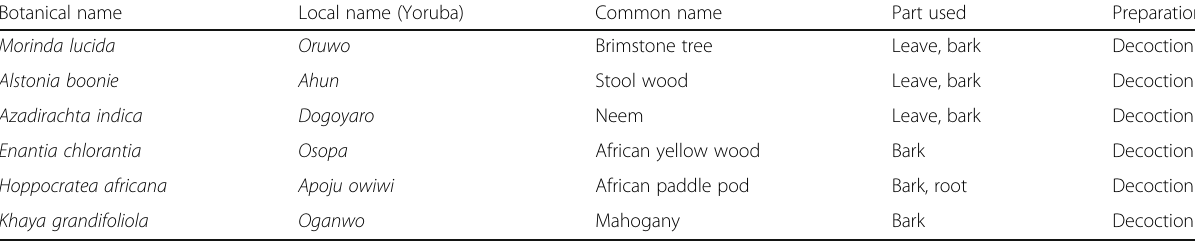
Table 1 Some plants used in malaria treatment in Akure Southwest Nigeria Botanical name